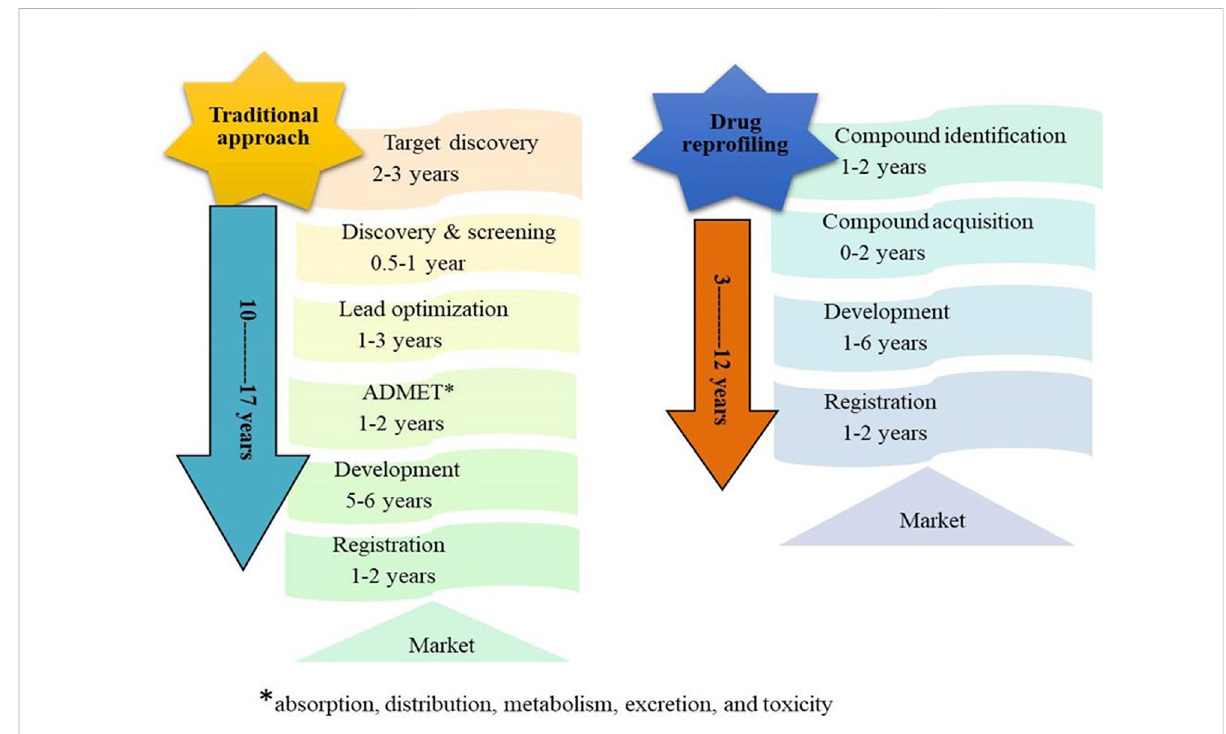
FIGURE 1 Comparison analysis between the traditional drug discovery approach and drug repro fi